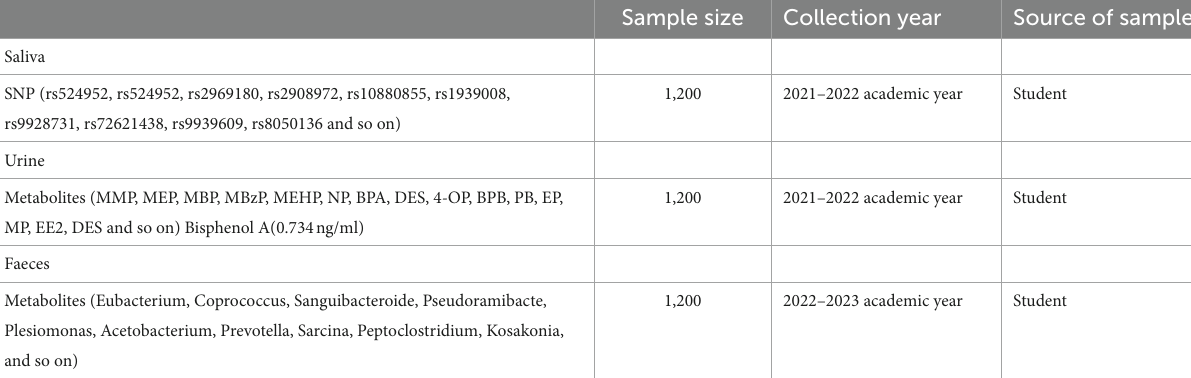
TABLE 4 Bio-sampling completion status